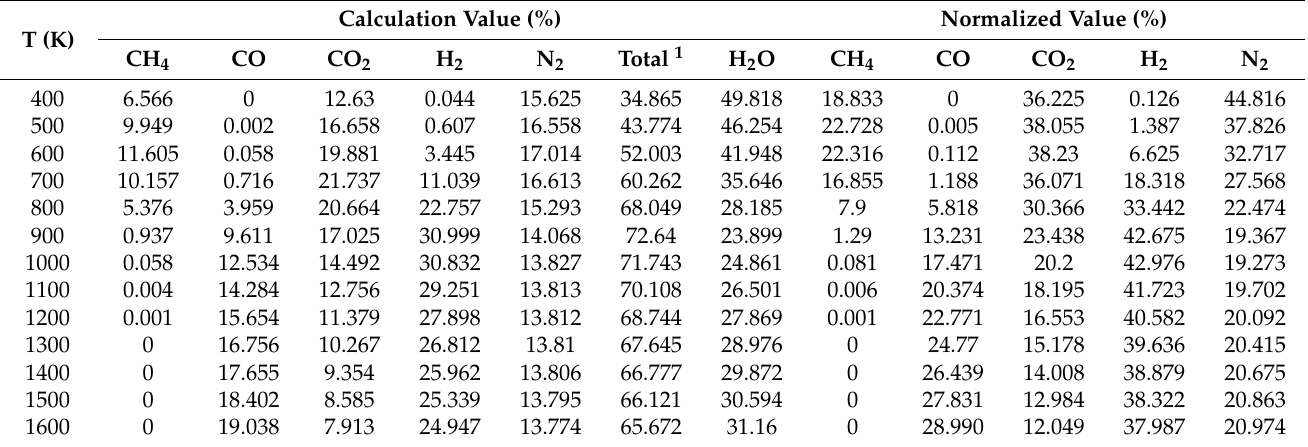
Table 4. The calculation value and the normalized value of CEA calculation at different temperatures.